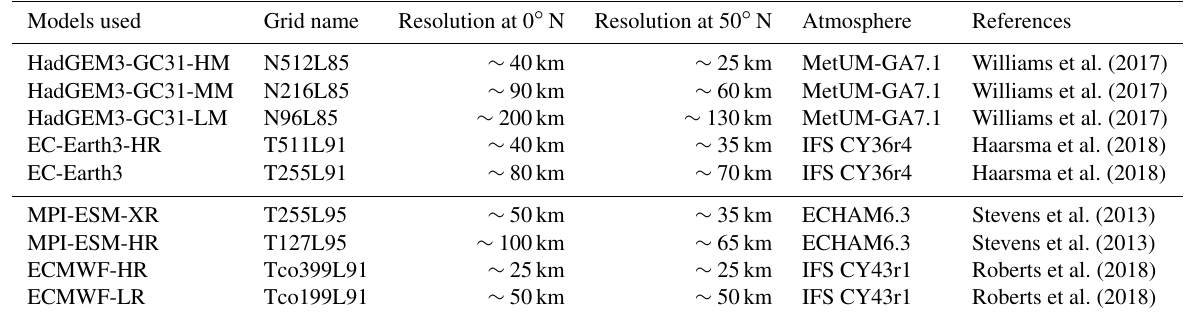
Table 1. List of the models analyzed in this study. Models used Grid